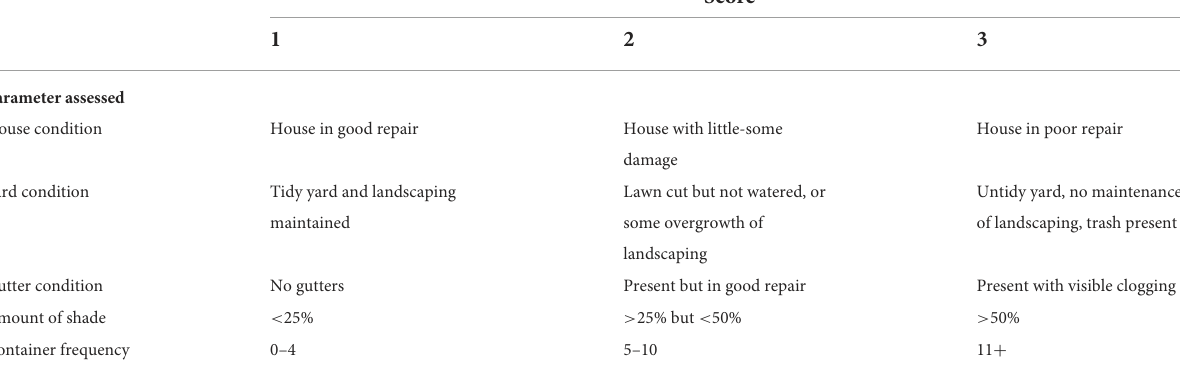
TABLE 1 Parameters used to calculate Premise Condition Index [modified from Tun-Lin et al.